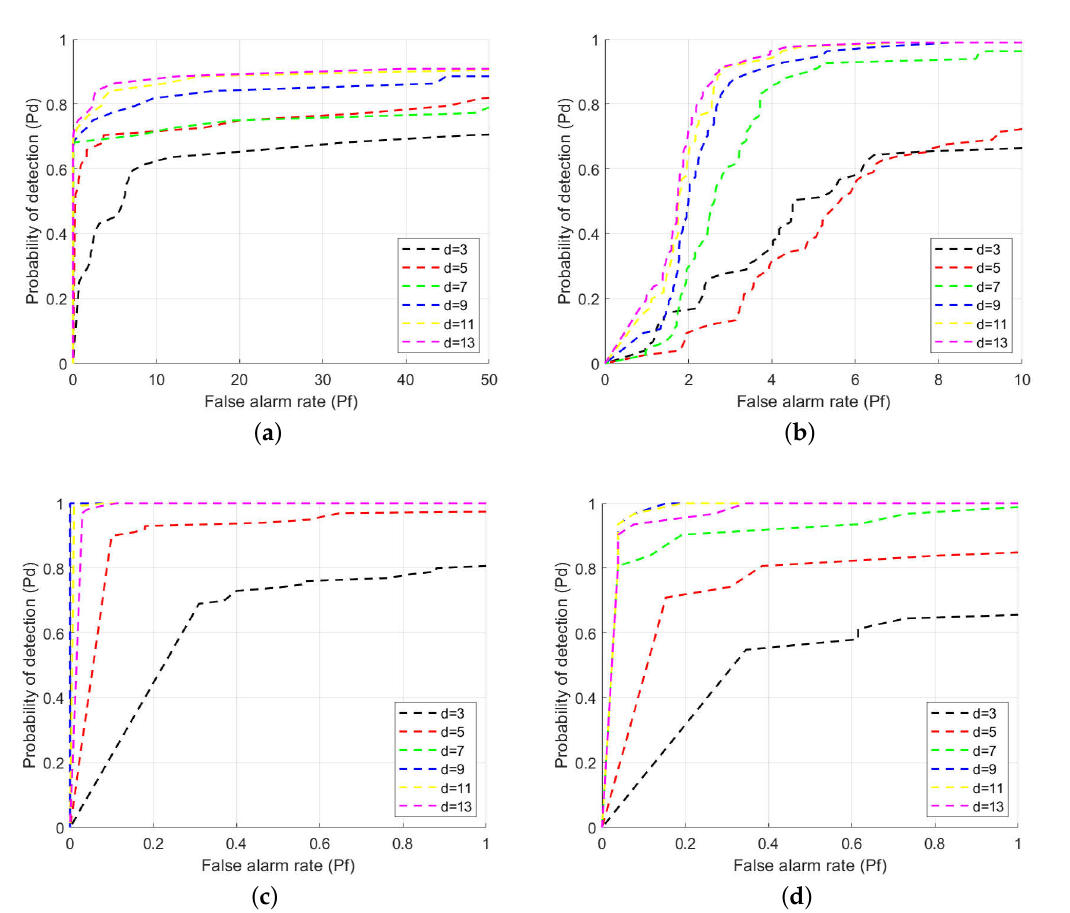
Figure 5. The receiver operating characteristic (ROC) performances for different sub-patch sizes d on the test dataset by using the proposed method: ( a ) Seq 1; ( b ) Seq 2; ( c ) Seq 3; and ( d ) Set R. Table 2. Mean local contrast ( LC ) of the images in Figure